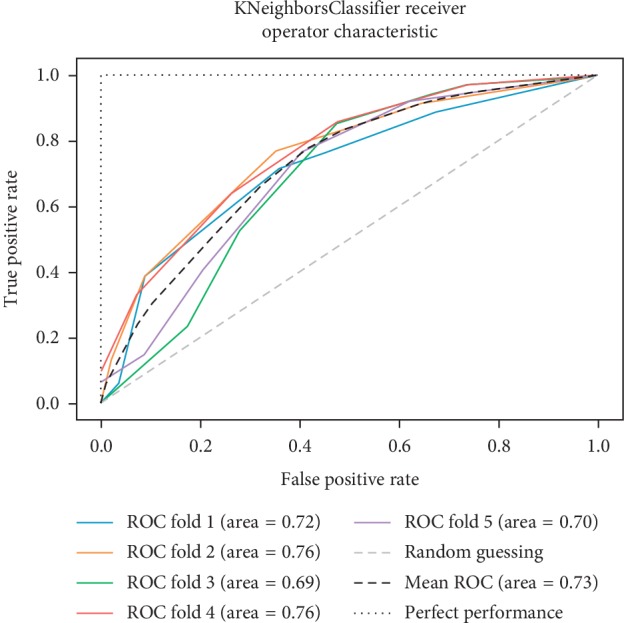
ROC curve for KNN.